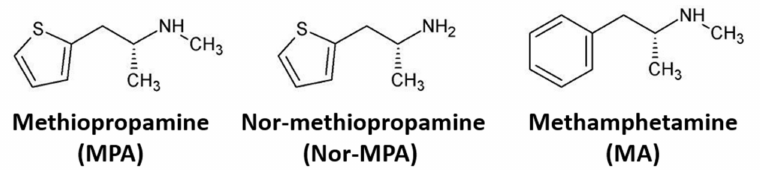
Figure 1. Structural formulas of methiopropamine (MPA), nor-methiopropamine (nor-MPA) and methamphetamine